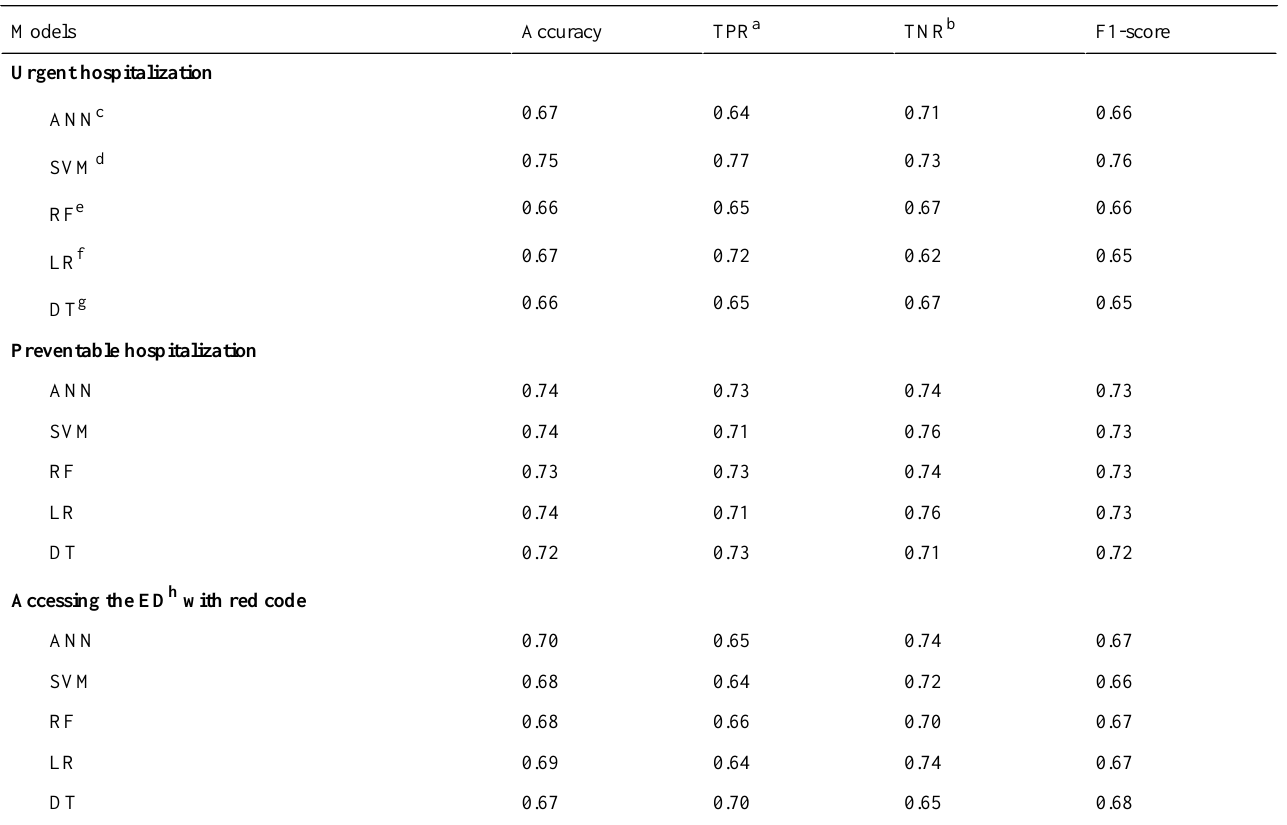
Table 6. Prediction results of models using a 10-fold cross-validation